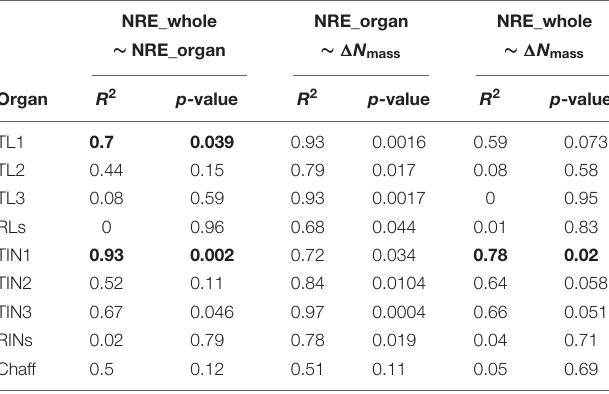
TABLE 2 | The coefficients of determination ( R 2 ) between whole plant and organ NRE, between organ NRE and organ (cid:49) N mass , and between whole-plant NRE and organ (cid:49) N mass among wheat organs.